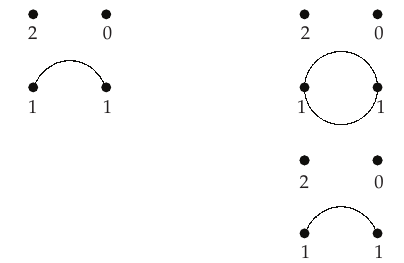
Figure 14: Tangles for E i and E i E − i E i , (cid:2) λ i ,λ i (cid:9) 1 (cid:3) (cid:8) (cid:2) 1 , 1 (cid:3)